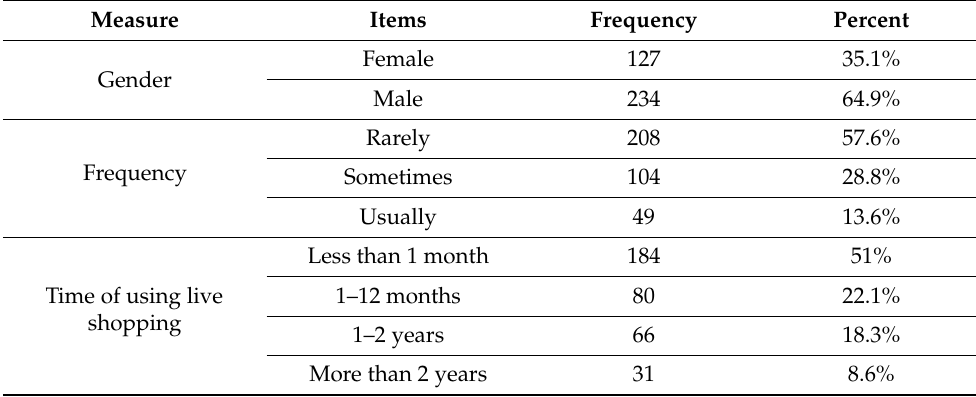
Table 3. Sample statistical structure.